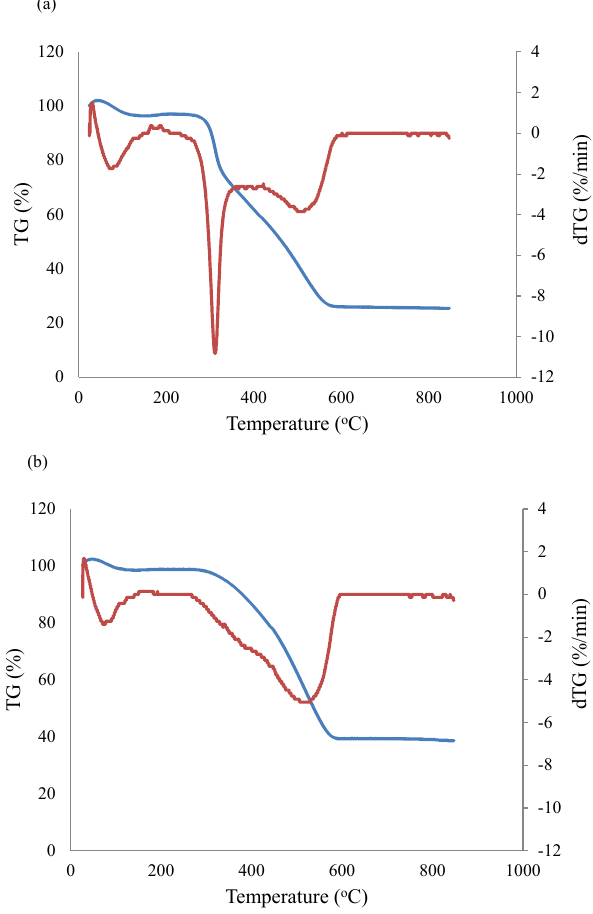
Figure 3. TG-dTG curves for the combustion profiles of (a) H-200- 6 and (b) Figure 3 . TG-dTG curves for the combustion profiles of (a) H-200-6 and (B) H-300-6